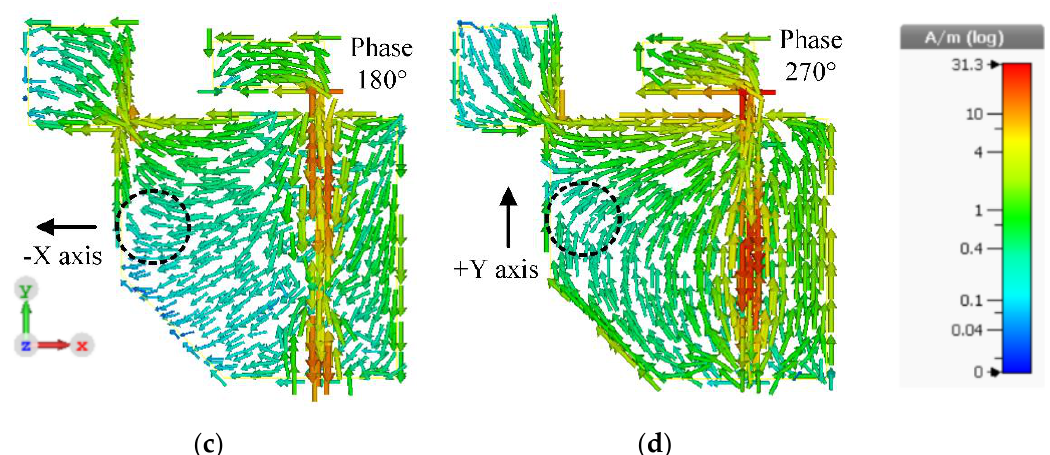
Figure 11. The surface current distribution on the proposed antenna (Antenna IV) at different phases: ( a ) 0 ◦ , ( b ) 90 ◦ , ( c )